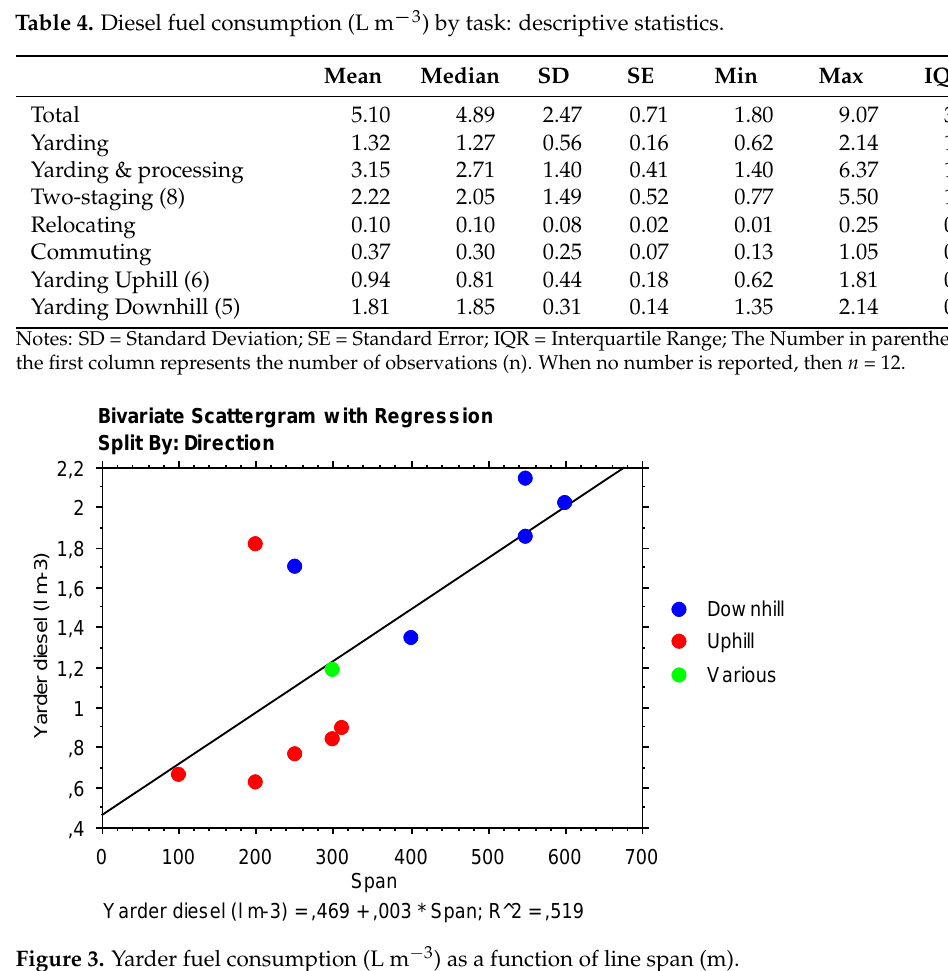
Table 4. Diesel fuel consumption (L m − 3 ) by task: descriptive statistics .